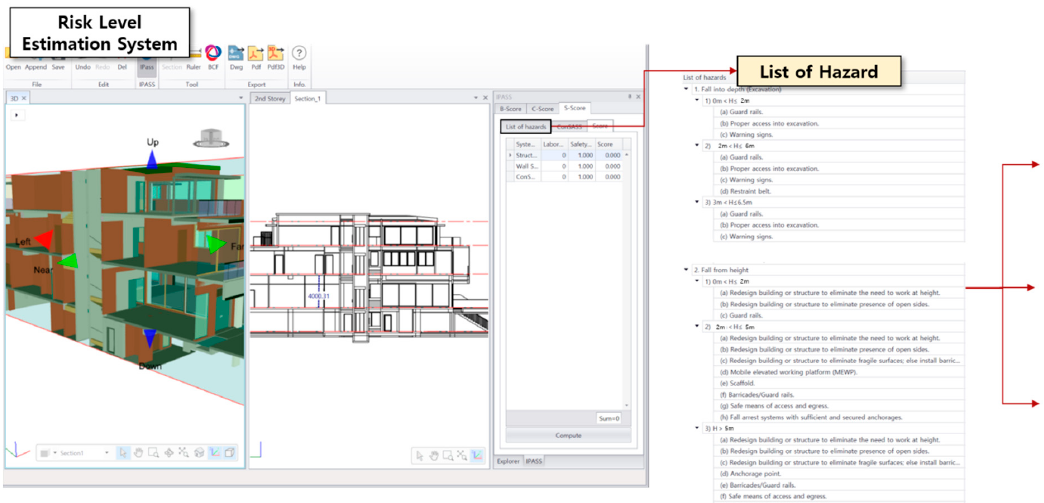
Figure 4. Results of the BIM-based risk assessment system.